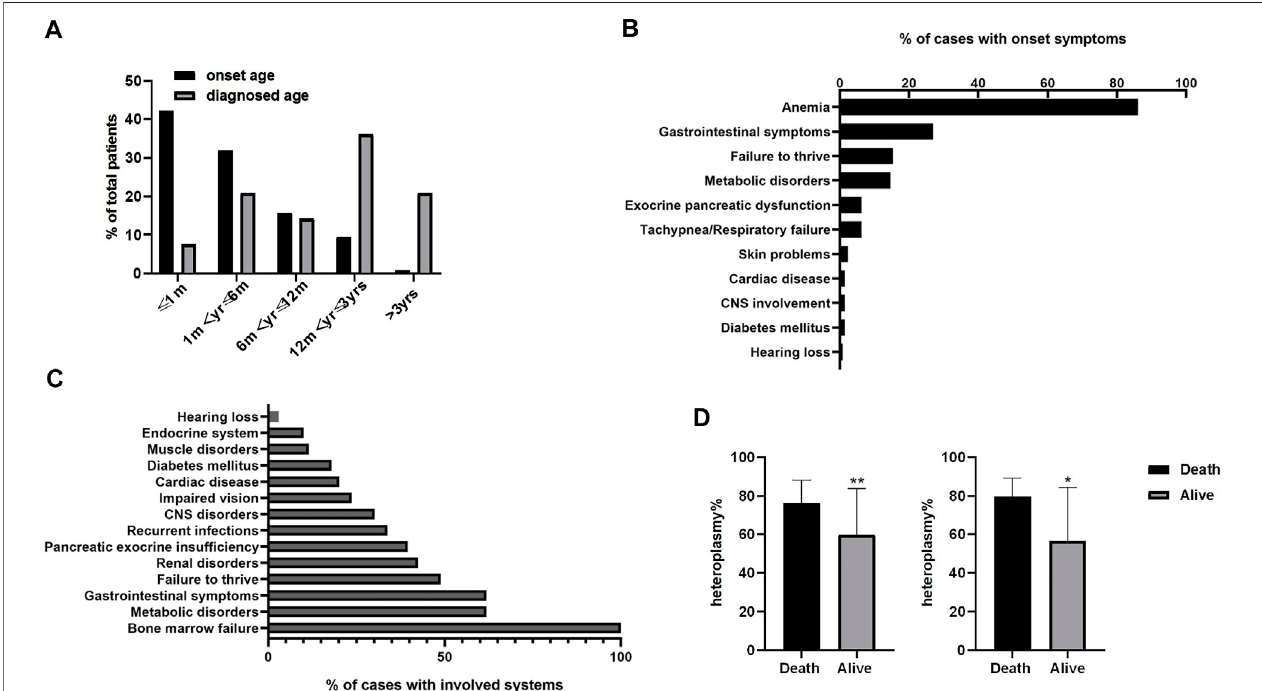
FIGURE4| Disease characteristics of139 patients. (A) Age ofonsetand diagnosistime from theonsetinPearson syndrome patients. (B) The percentage ofinitial symptoms observed in patients. (C) The percentage of symptoms observed in patients during the course of the disease. a refers to diarrhea and vomiting; b refers to hypothyroidism, growth hormone de fi ciency, and adrenal insuf fi ciency. (D) Comparison of mitochondrial mutation heteroplasmy in peripheral blood between the death groupandthesurvivalgroup.ThemeanheteroplasmyofmitochondrialDNAmutationinperipheralbloodwasstatisticallyhigherinthedeaths(76.29±11.86%, n = 29) than that in survivals (59.92 ± 23.87%, n = 26; t = 3.272, p < 0.01. left). For patients with 4.977 kb deletion (right), the mean heteroplasmy of mitochondrial DNA mutationgenesinperipheralbloodwasstatisticallyhigherinthedeaths(79.64±9.71%, n =11)thanthatinsurvivals(56.67±27.65%, n =9)( t =2.58, p < 0.05).Errorbar represents the SD of heteroplasmy from peripheral blood in the deaths and survivals groups. Supplementary data S1 The data of patients summarized from the literature review. Supplementary data S2 Correlation between heteroplasmy of mitochondrial DNA deletion in peripheral blood and the age of onset. Supplementary data S3 Correlation between heteroplasmy of 4.977 kb deletion in peripheral blood and the age of